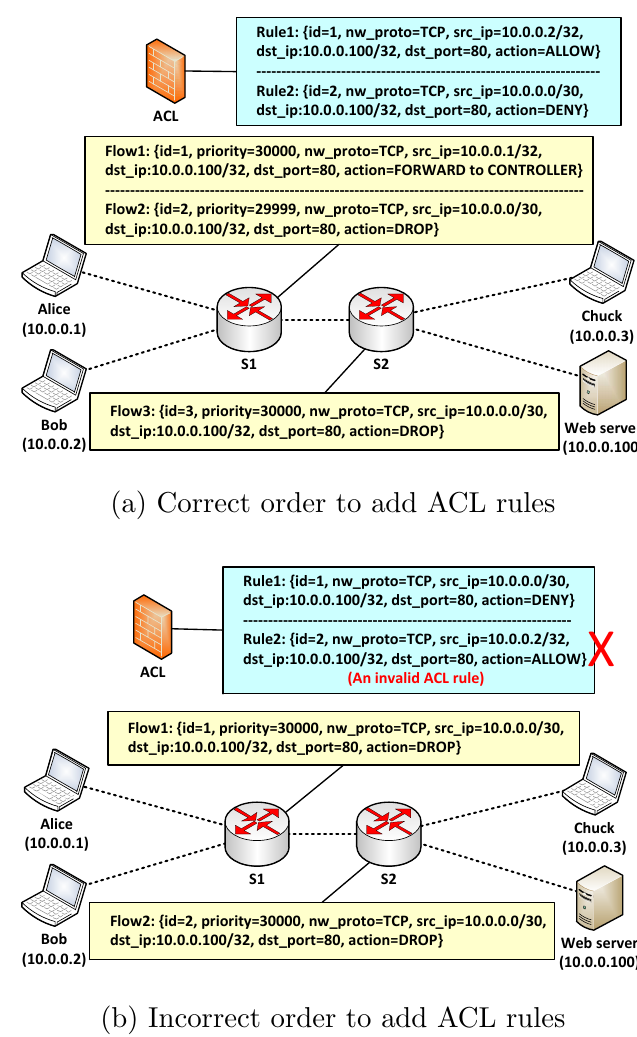
Figure 4. An example for the order to add ACL rules